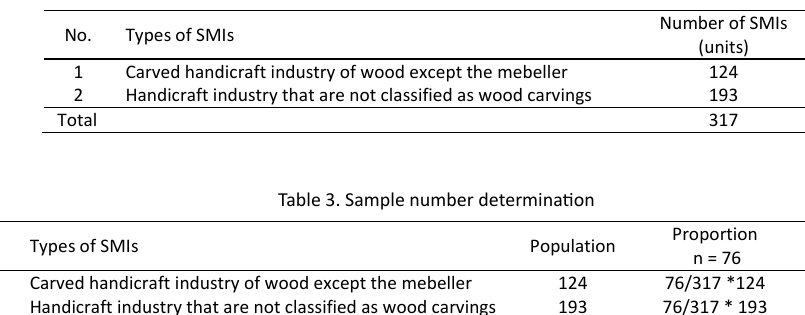
Table 2 : Types of small and medium industries (SMIs) crafts in Denpasar Year 2016 (DBICDY, 2016)